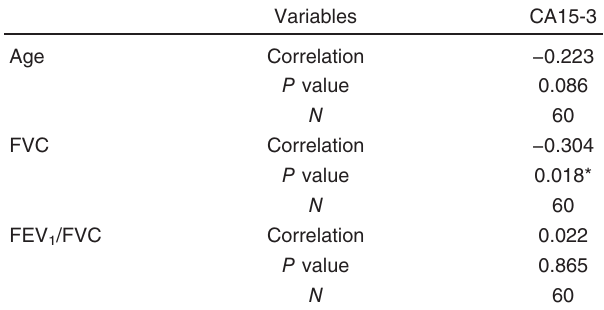
Table 5 Correlations between carbohydrate antigen 15-3 and age, forced vital capacity, and forced expiratory volume in